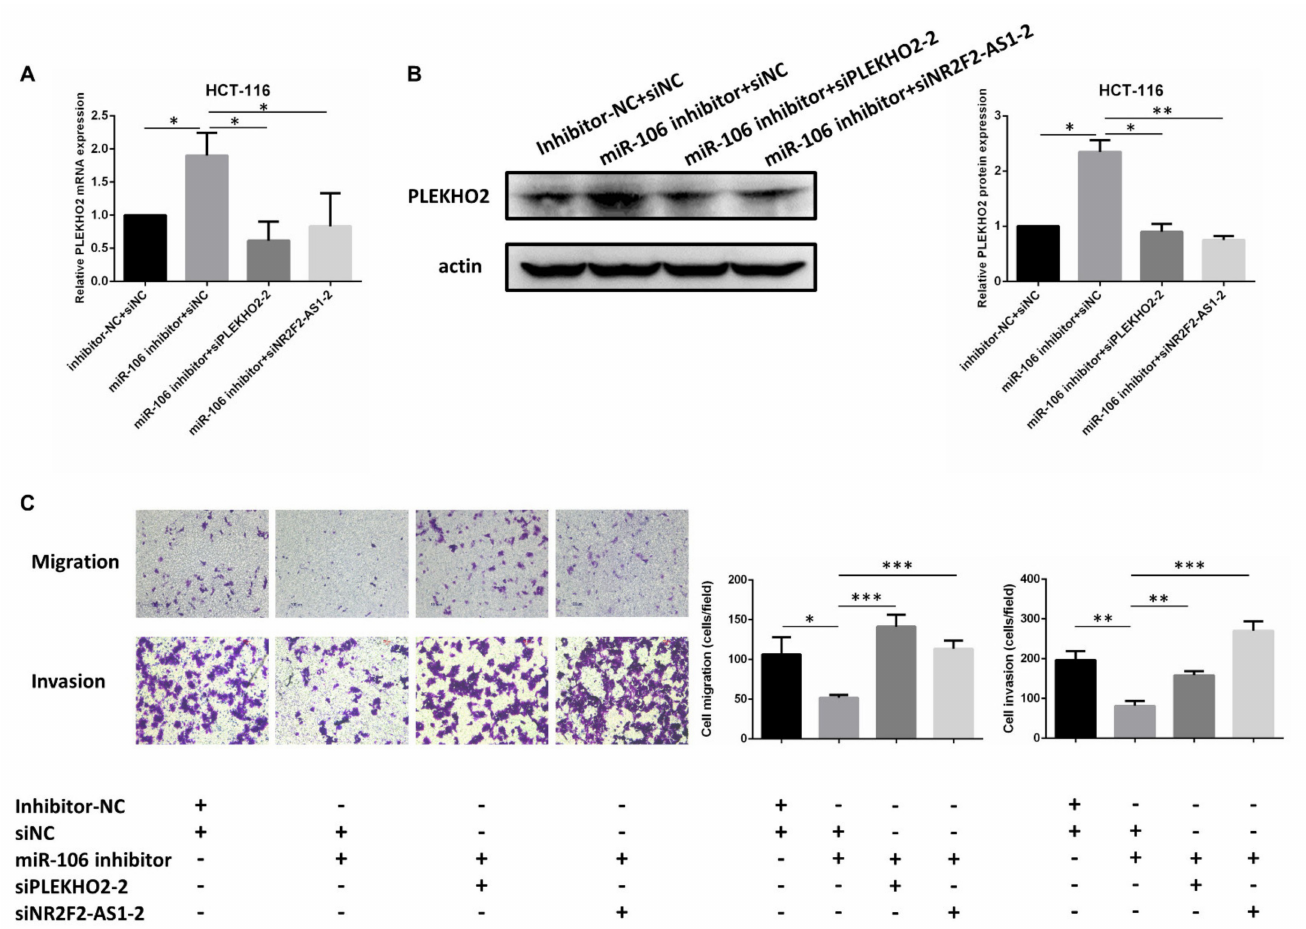
Figure 7. NR2F2-AS1 attenuates PLEKHO2 expression. ( A , B ) The mRNA and protein expression of PLEKHO2 was analyzed after co-transfection with PLEKHO2 siRNA or NR2F2-AS1 siRNA and miR-106b inhibitor in HCT-116 cells. ( C ) Transwell assay showed that transfection of miR-106b inhibitor suppressed HCT-116 cell migration and invasion. Co-tranfection of PLEKHO2 siRNA or NR2F2-AS1 siRNA in HCT-116 cells rescues the miR-106b inhibitor-induced migration suppression. All data are shown as the mean ± SD ( n = 3), * p < 0.05, ** p < 0.01, *** p <